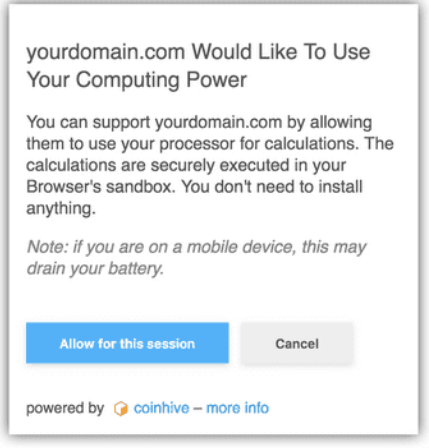
Figure 2. Authedmine notice